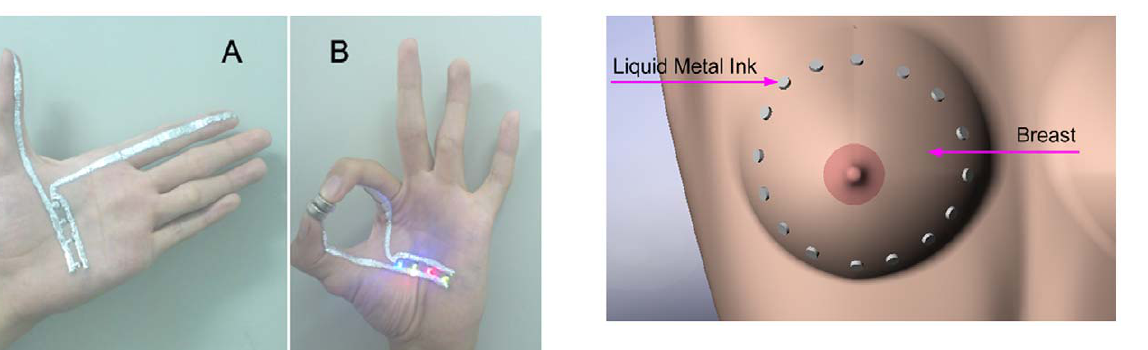
Figure 7. A 3D model of using liquid metal ink as breast EIT